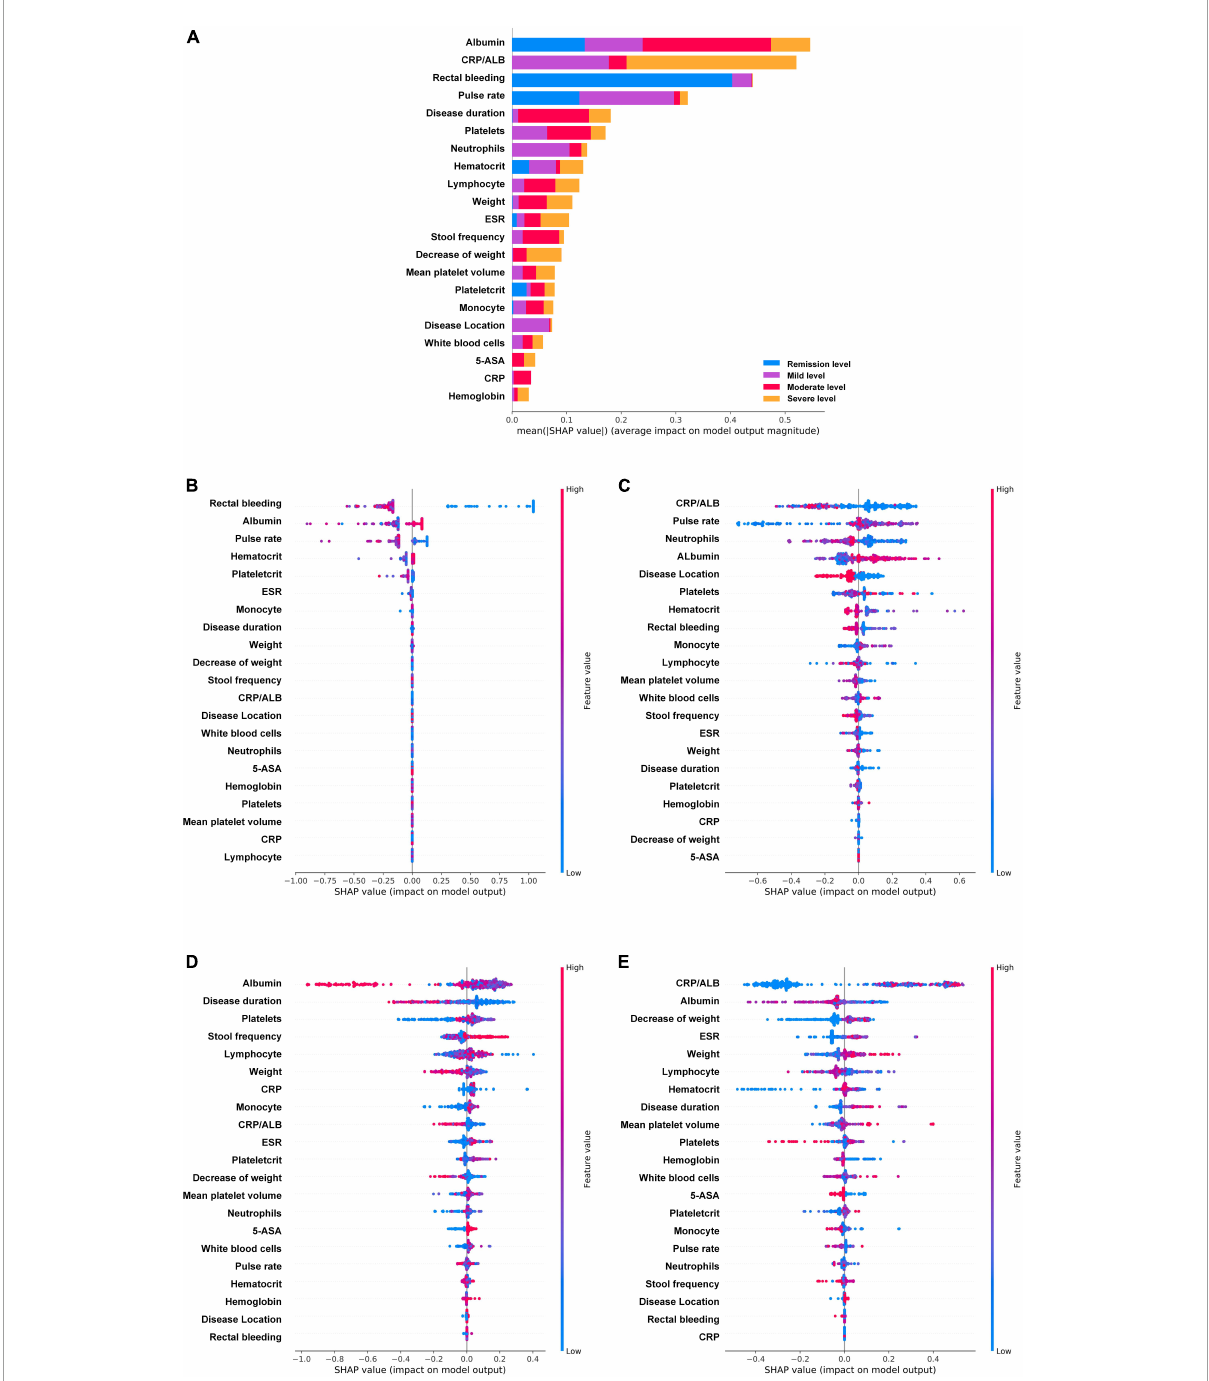
FIGURE5 Feature importance ranking based on Shapley additive explanations (SHAP) values in ulcerative colitis endoscopic index of severity score based XGboost model. (A) The contribution of each variable to the overall model. The different colors represent the contribution given by the variable under that classification. (B–E) Analysis of all variables’ SHAP values at each classification level, each point in the figure represents a sample. The variables are ranked according to the sum of the SHAP values for all patients in the remission level (B) , mild level (C) , moderate level (D) , and severe level (E) . Red indicates that the value of a variable is high, and blue indicates that the value of a variable is low. The x-axis indicates the effect of SHAP values on the model output. The larger the value of the x-axis, the greater the probability of this level. ESR, erythrocyte sedimentation rate; CRP, C-reactive protein; ALB, albumin; 5-ASA, 5-aminosalicylic